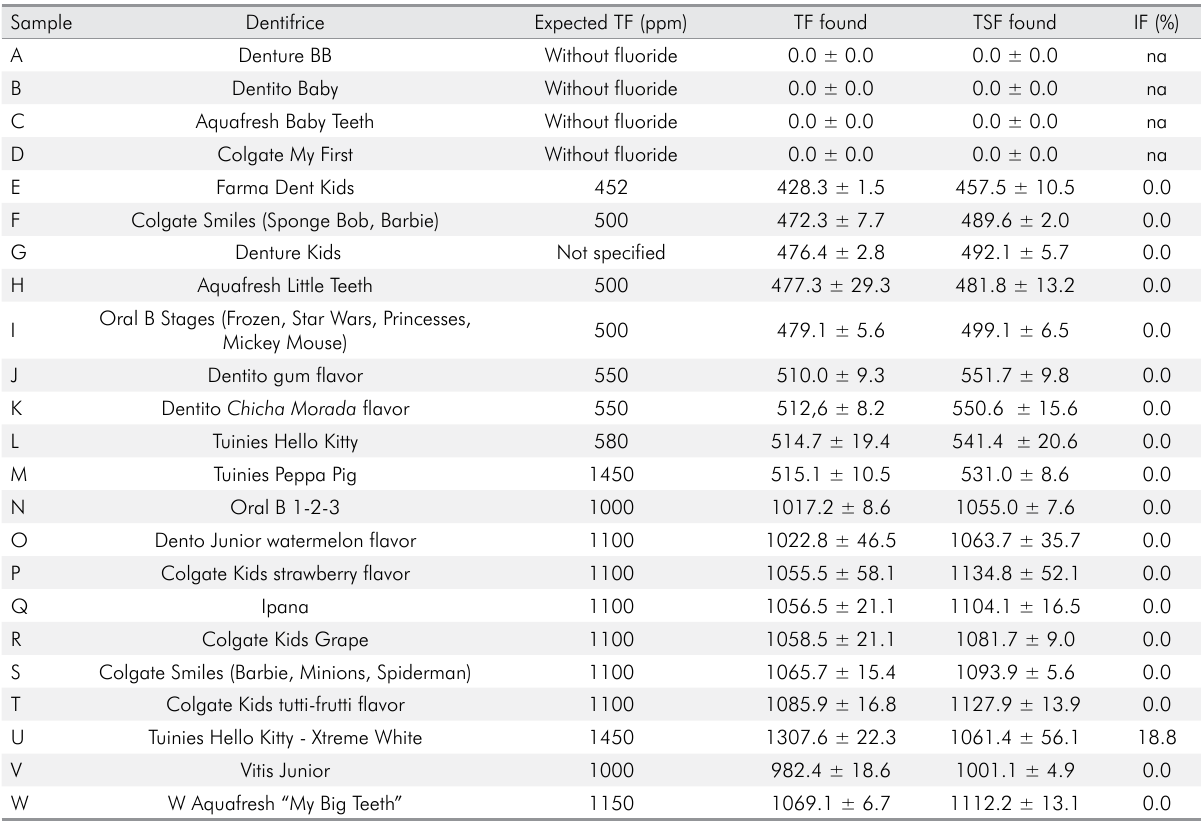
Table 2. As declared on label: total fluoride (TF) and total soluble fluoride (TSF) concentration (mg F/kg) found, and % of insoluble fluoride (IF) in the dentifrices analyzed (average ± sd; n =